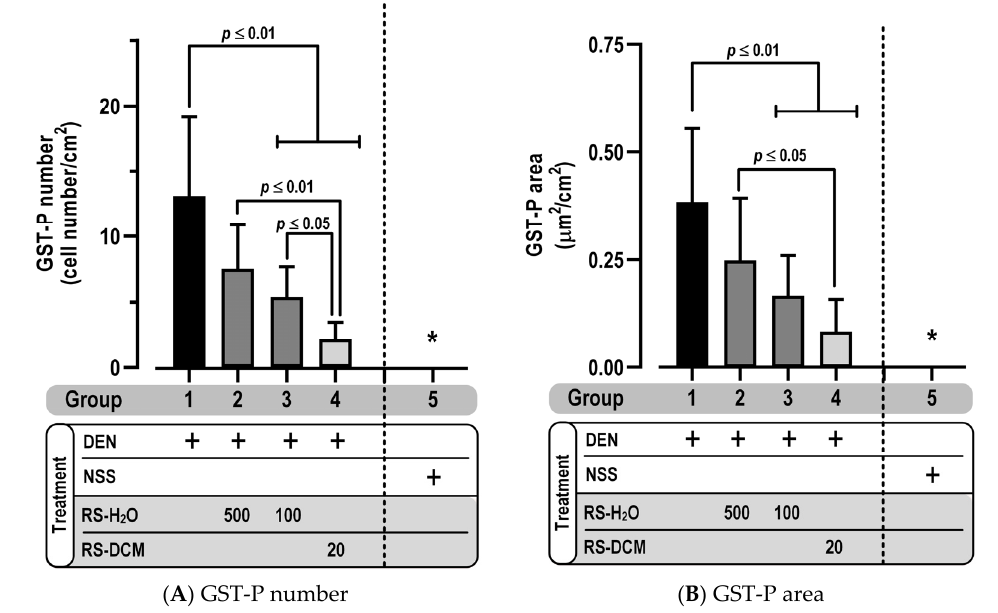
Figure 4. The e ff ect of RS on GST-P positive foci formation as represented by a number ( A ) or area ( B ) per liver area (cm 2 ). The values are expressed as mean ± SD. * There are no GST-P positive foci detected in any of the NSS treatment groups (group 5–8). The data display non-normal distribution (Shapiro–Wilk: p ≤ 0.05) and were analyzed for statistical signi fi cance using the non-parametric Mann–Whitney U test. RS dosage unit is mg/kg BW.